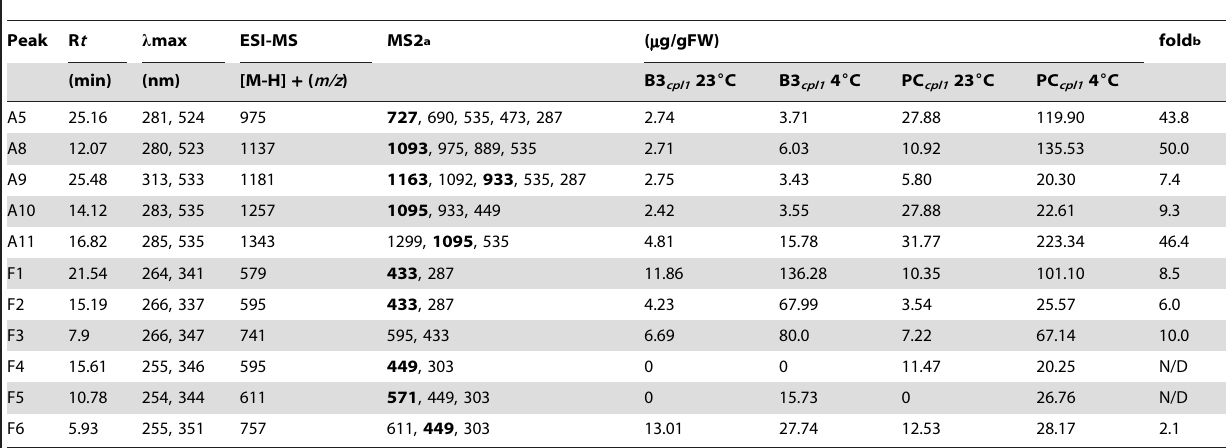
Table 2. Flavonoid phytochemicals identified by LC-MS analysis.